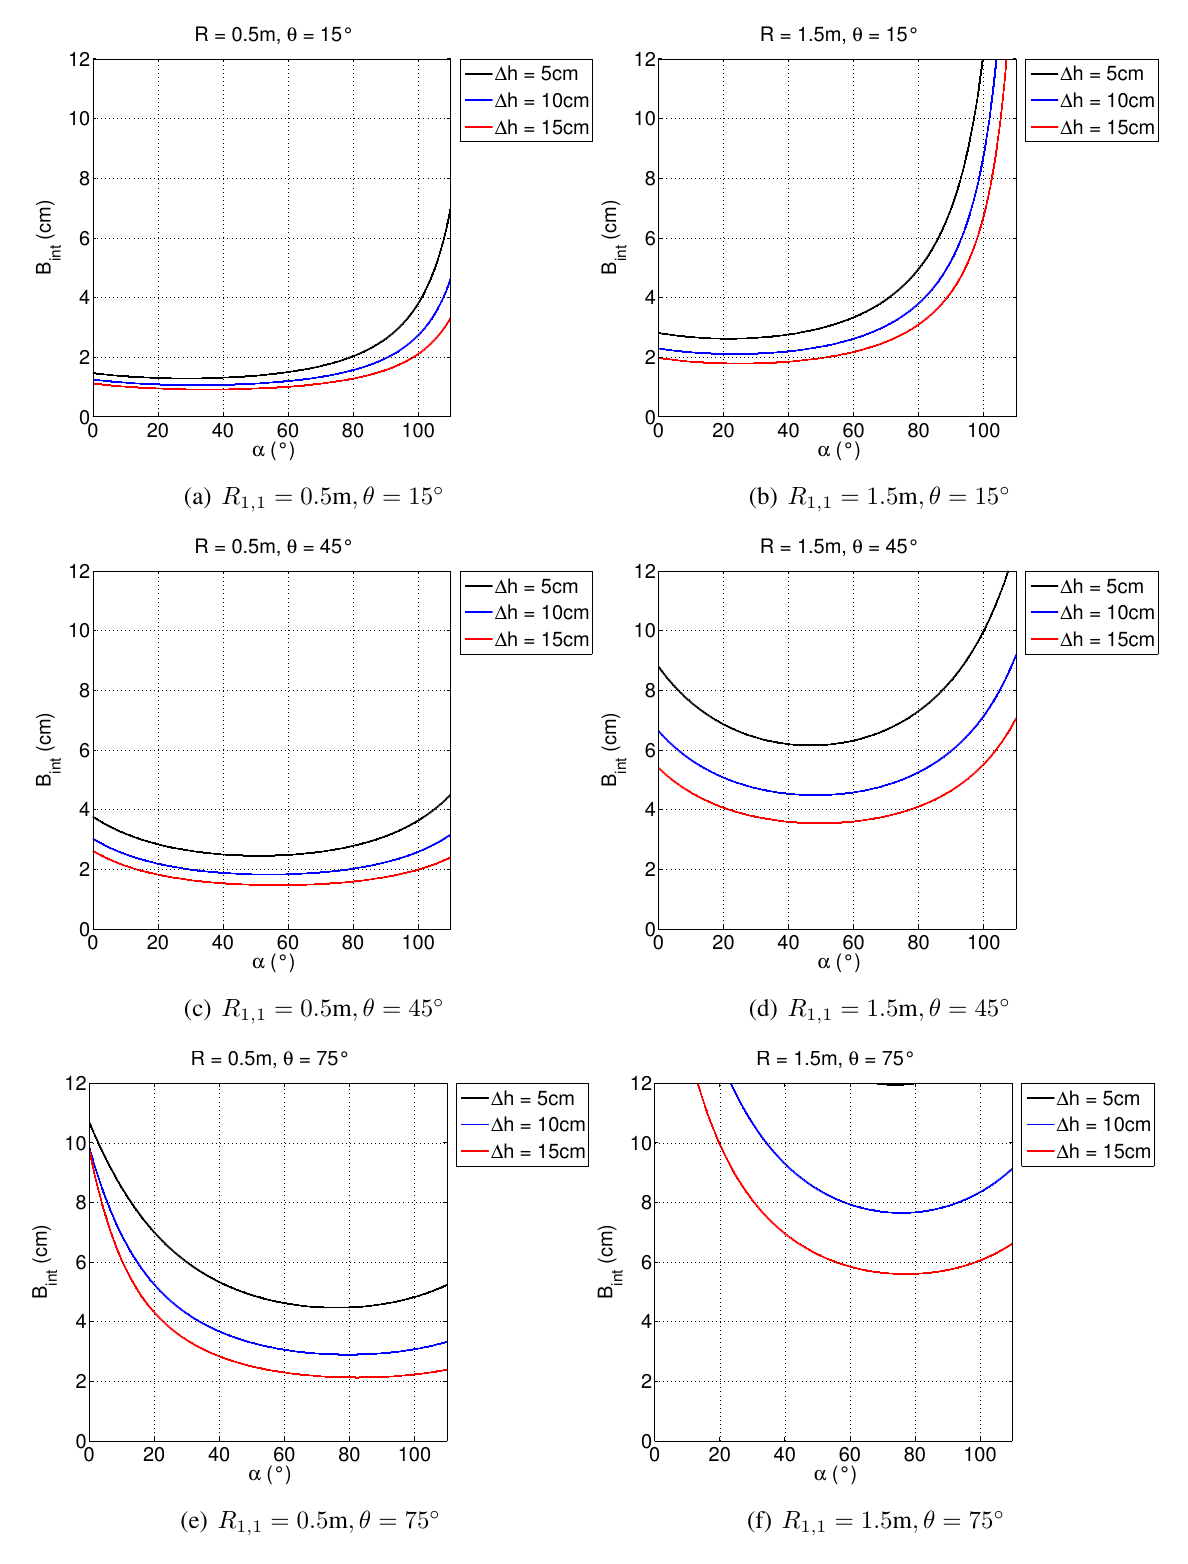
Figure 8. Effect of height variation on the critical baseline. For each plot, dr = 10 cm has been